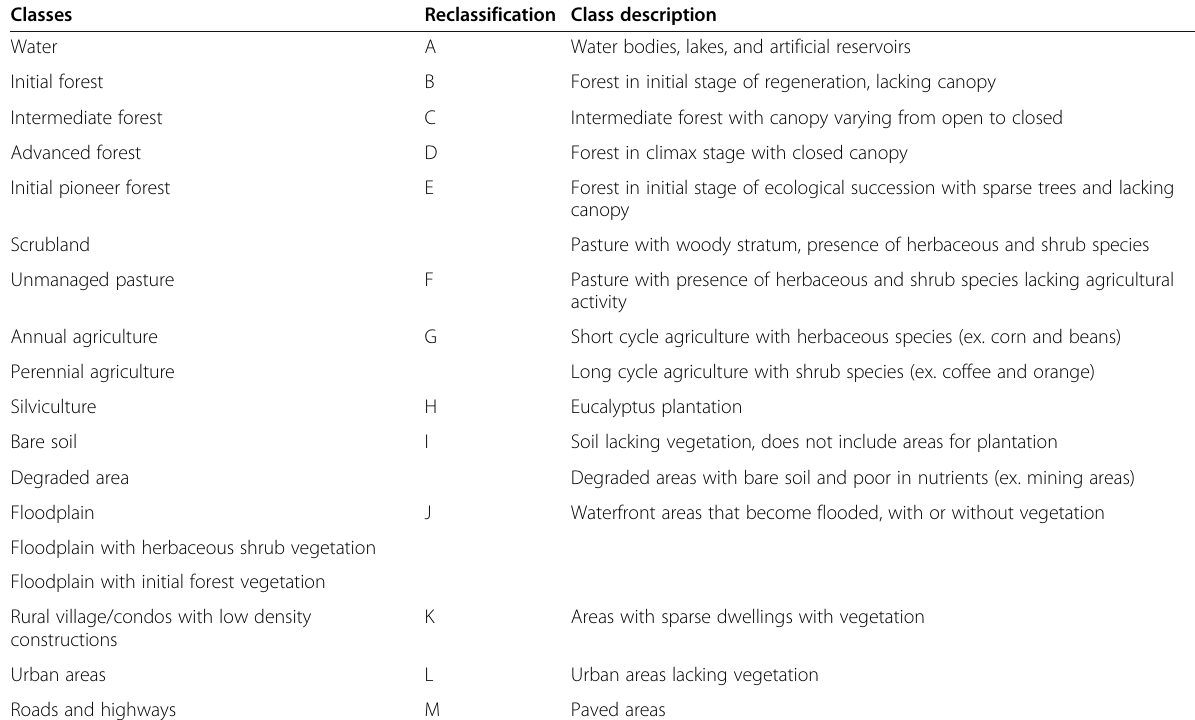
Table 1 Land cover reclassification according to similarities of environmental structure